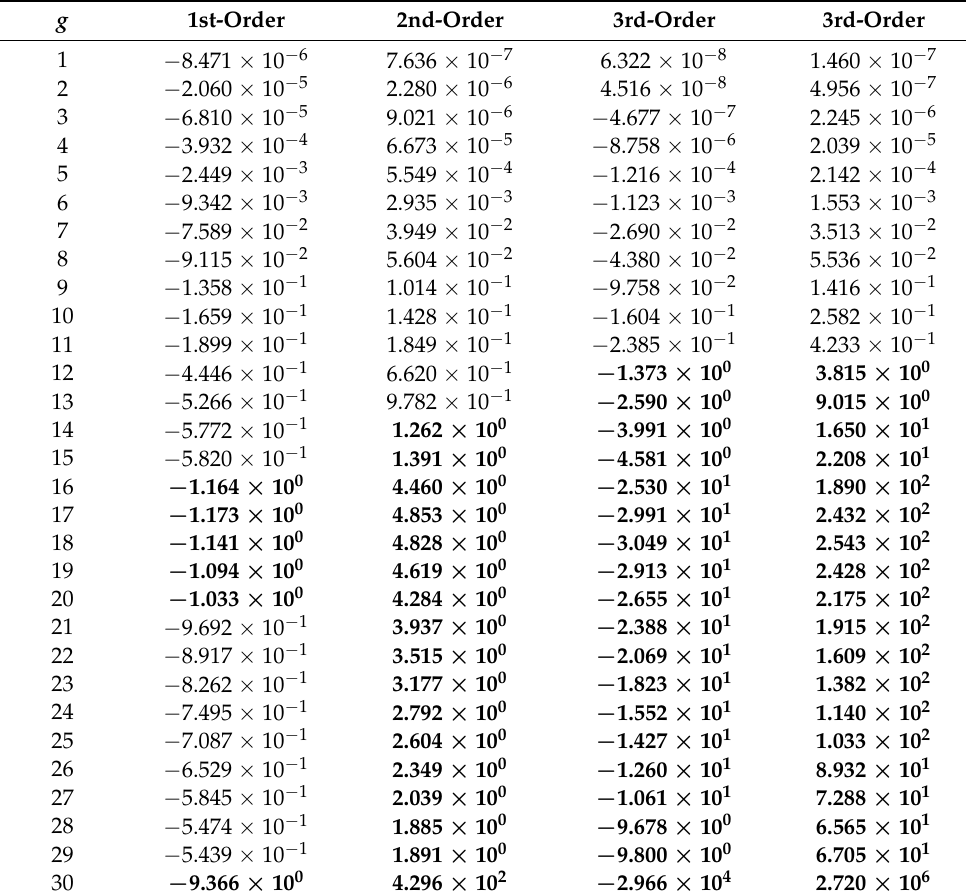
Table 7. Comparison of 1st-order through 4th-order unmixed relative sensitivities, S ( 1 ) (cid:17) (cid:17) (cid:16) (cid:17) (cid:16) (cid:16) S ( 2 ) σ g σ g σ g , g = 1, . . . ,30, for isotope 6 ( 1 , σ g , σ g , σ g , S ( 4 ) , σ g , σ g , S ( 3 ) , σ g t ,6 t ,6 t ,6 t ,6 t ,6 t ,6 t ,6 t ,6 t ,6